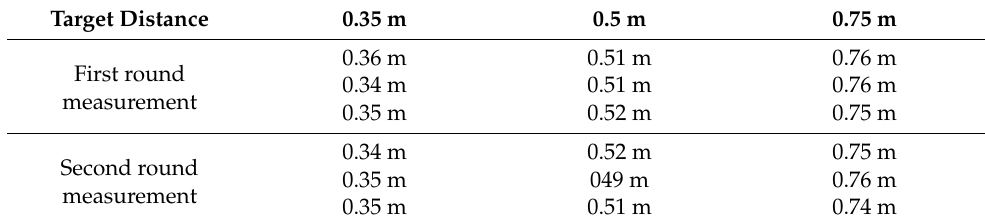
Table 1. Experimental results of object distance measurement.